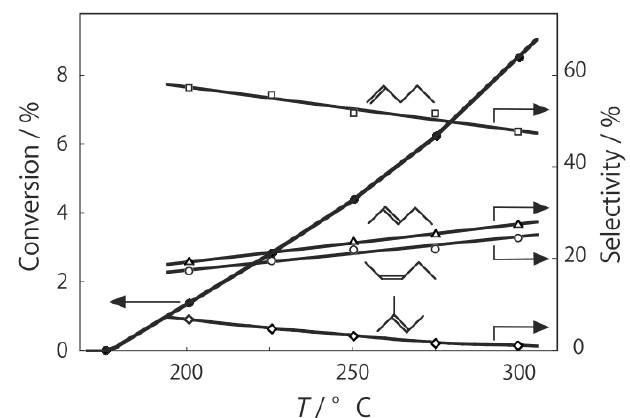
Figure 33. Effect of temperature on reactivity and selectivity for dehydrohalogenation of 1-chloropentane over [(Nb activation of the cluster (30 mg, 17 μmol) under helium (1.2 L/h) for 1 h, reaction was commenced by introduction of 1-chloropentane (0.20 mL/h, 1.66 mmol) without changing the